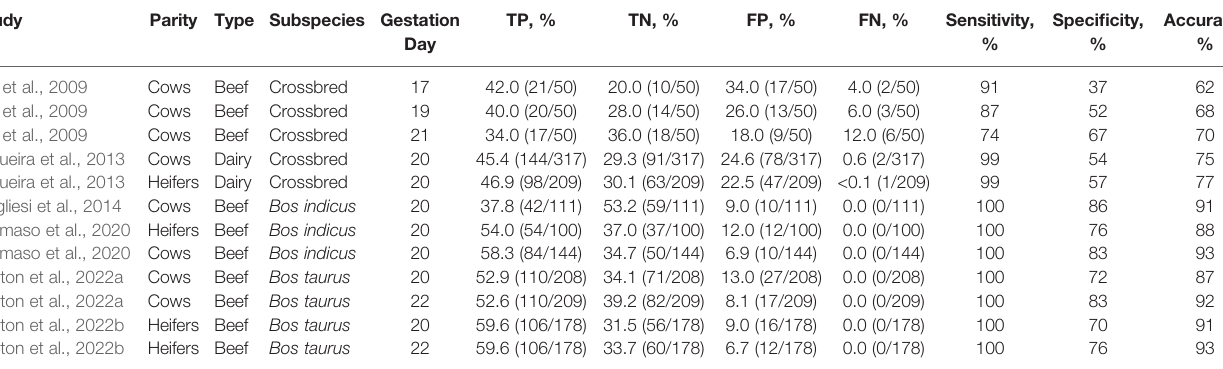
TABLE 1 | Summary of estimates of agreement between luteal color Doppler ultrasonography and conventional ultrasonography to diagnose pregnancy in cattle 1 .